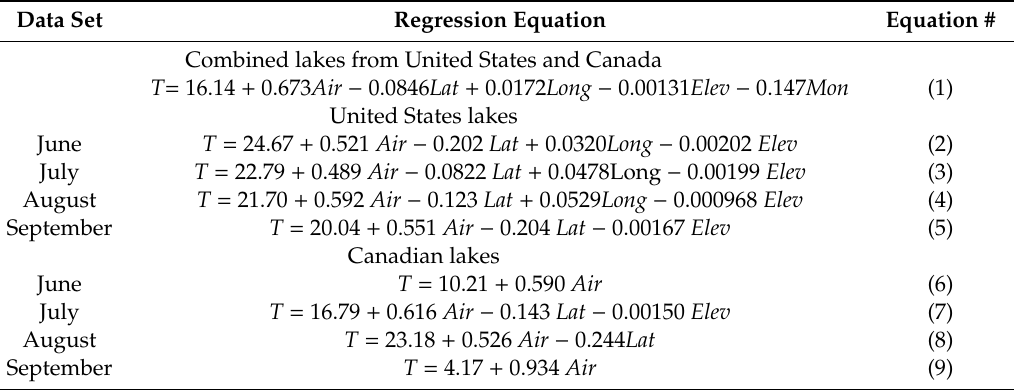
Table 5. Empirical relationships with lake water temperatures at 1 m depth for lakes in Canada and the United States sampled in the months of June–September where T ( ◦ C) is a measured water temperature at 1-m, Long is the longitude of the lake, Lat is the latitude of the lake, Elev is the elevation above sea level (m) of the lake, Air is the 8-day average air temperature ( ◦ C) at the lake ending on the day of sampling and Mon are the summer months (6, 7, 8 and 9) listed in order. Equation numbers are in